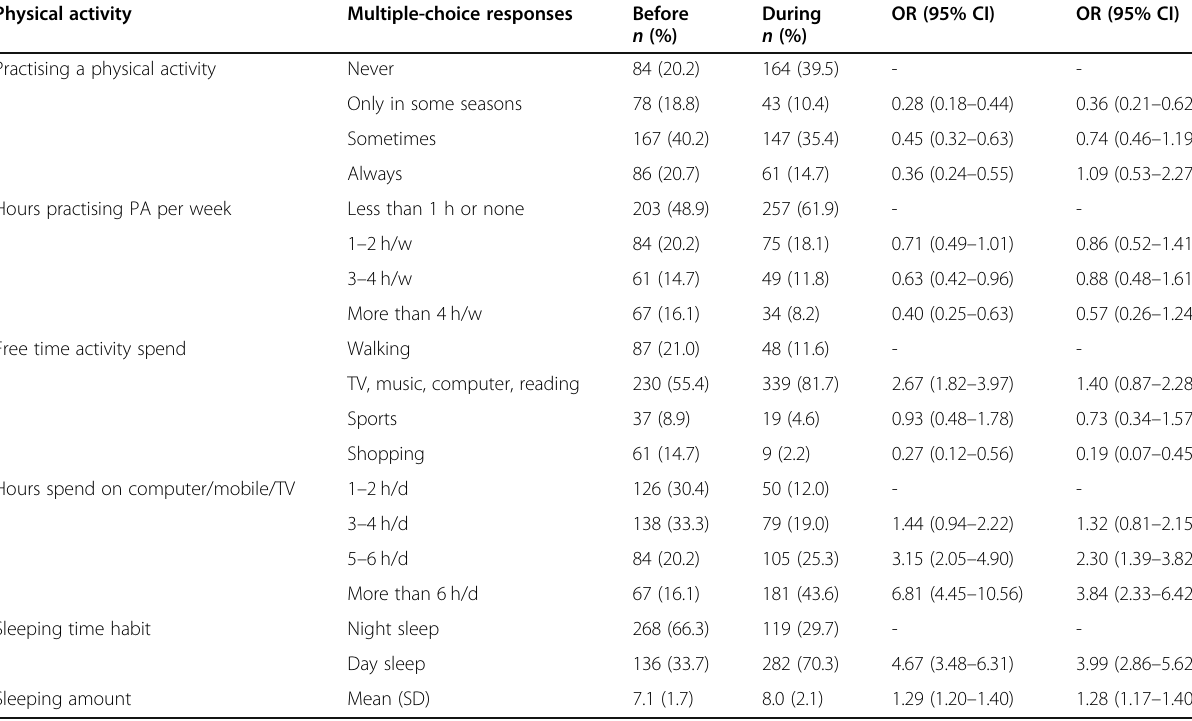
Table 5 Multivariate analysis between two periods using logistic regression for physical activity Physical